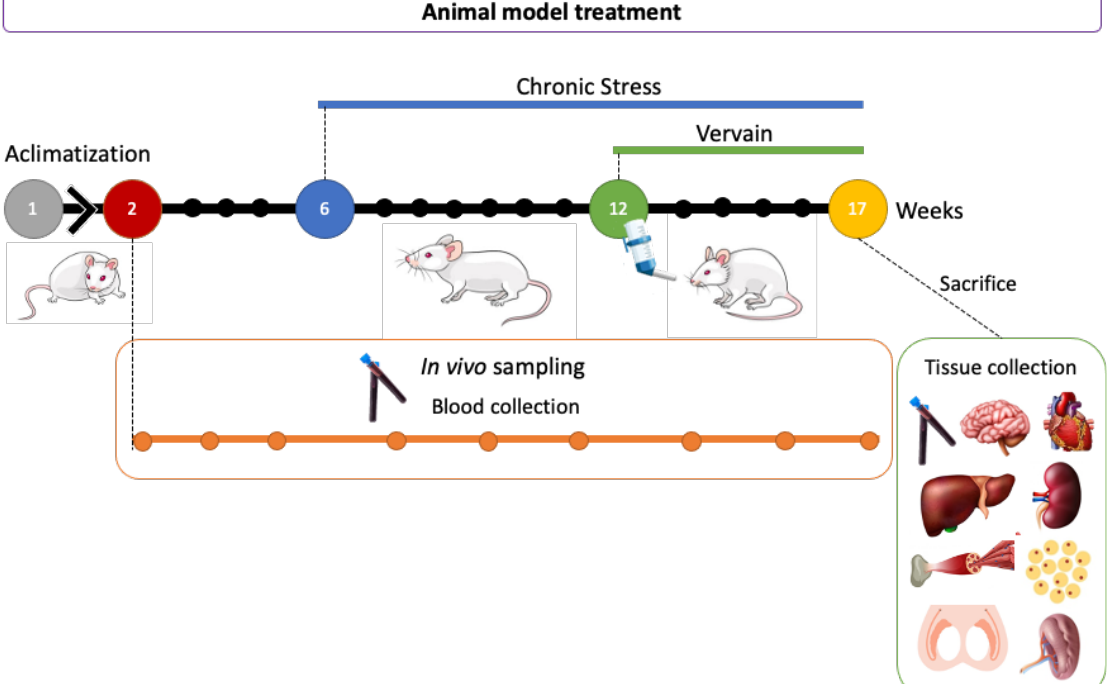
Figure 12. Temporal diagram representation of the in vivo protocol. Animals were acclimatized to the local conditions for 7 days. Then, three blood samples per animal were collected for each experimental condition: under no training induction or herbal gavage, submitted to chronic stress, and finally when orally given vervain (200 mg/kg) tisane. Animals were left to recover for some days (12 days) between each blood collection. Vervain was administered for about a month to evaluate longer exposure effects. Finally, all the animals were sacrificed. In total, nine blood samples per animal were collected, with three per experimental condition (normal, under stress, and under stress with vervain consumption). Several solid tissues were also collected for further analysis as follows: liver, kidney, spleen, testis, epididymis, heart, brain, skeletal muscle, and fat tissue (white adipose